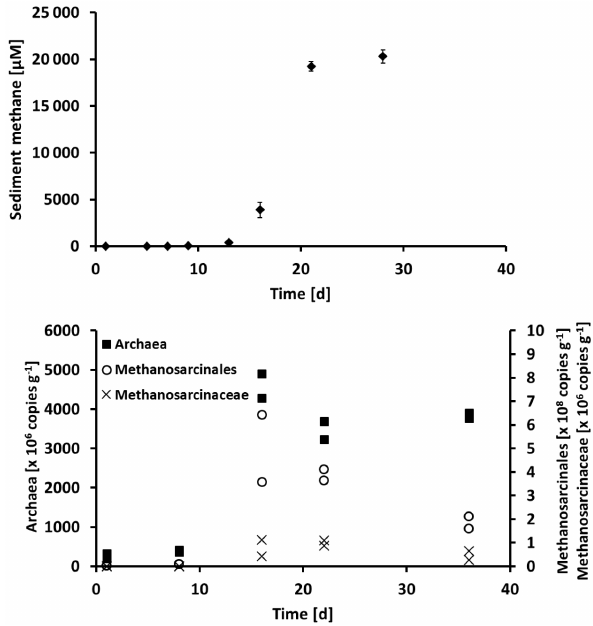
Figure 8. Sediment methane concentrations (with sediment from the 0–1cmb.s.f. in September 2014) over time in the treatment with the addition of methanol (10mM) are shown above. Shown are triplicate values per measurement. DNA copies of Archaea, Methanosarcinales, and Methanosarcinaceae are shown below in duplicates per measurement. Please note the secondary y axis for Methanosarcinales and Methanosarcinaceae. More data are avail- able for methane (determined in the gas headspace) than from DNA samples (taken from the sediment) as sample volume for molecular analyzes was